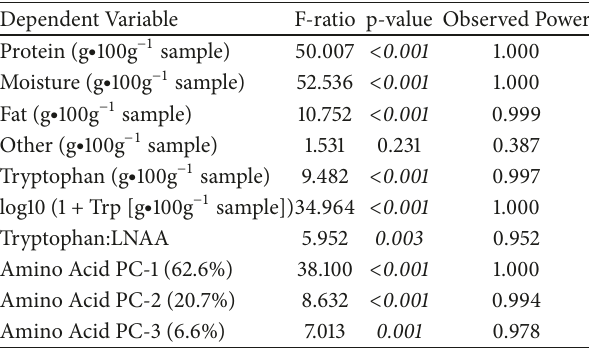
Table 9: 1-Way ANOVA Comparing Types of Wild